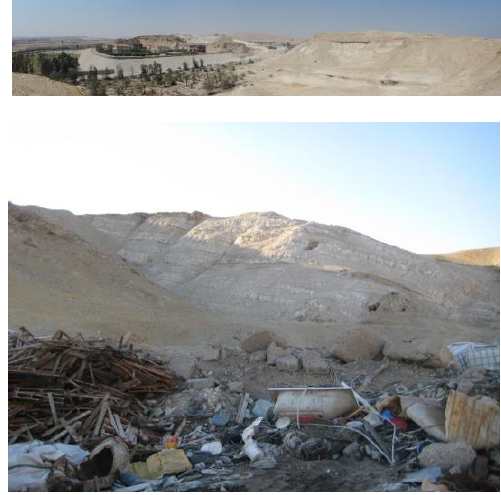
Figure 9a and b: Limestone quarries in the